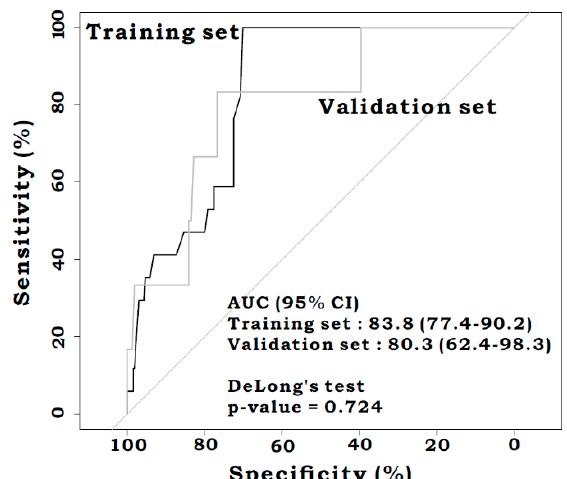
Figure 2. Receiver operating characteristic curves for the modified CLS (m-CLS) in the training set and the validation set. No significant difference of AUROC was seen between the train and validation sets (AUROC 0.838 versus 0.803, p = 0.724).